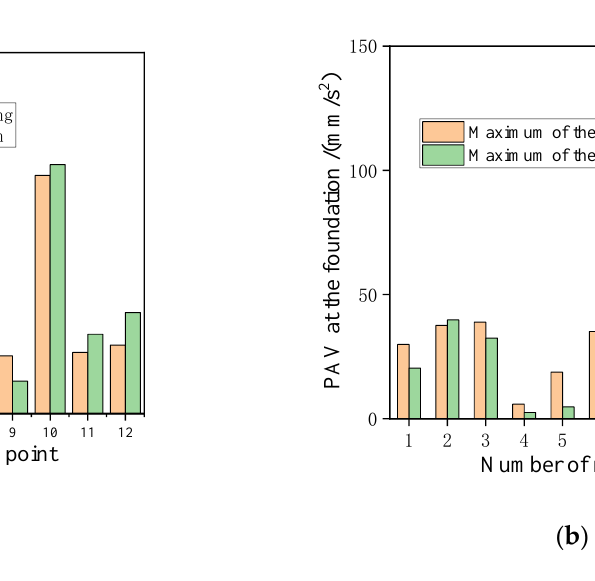
Figure 9. Monitoring results of deformation of arch ribs: ( a ) Monitoring result of vertical deformation of arch ribs; ( b ) Monitoring result of longitudinal deformation of arch ribs.